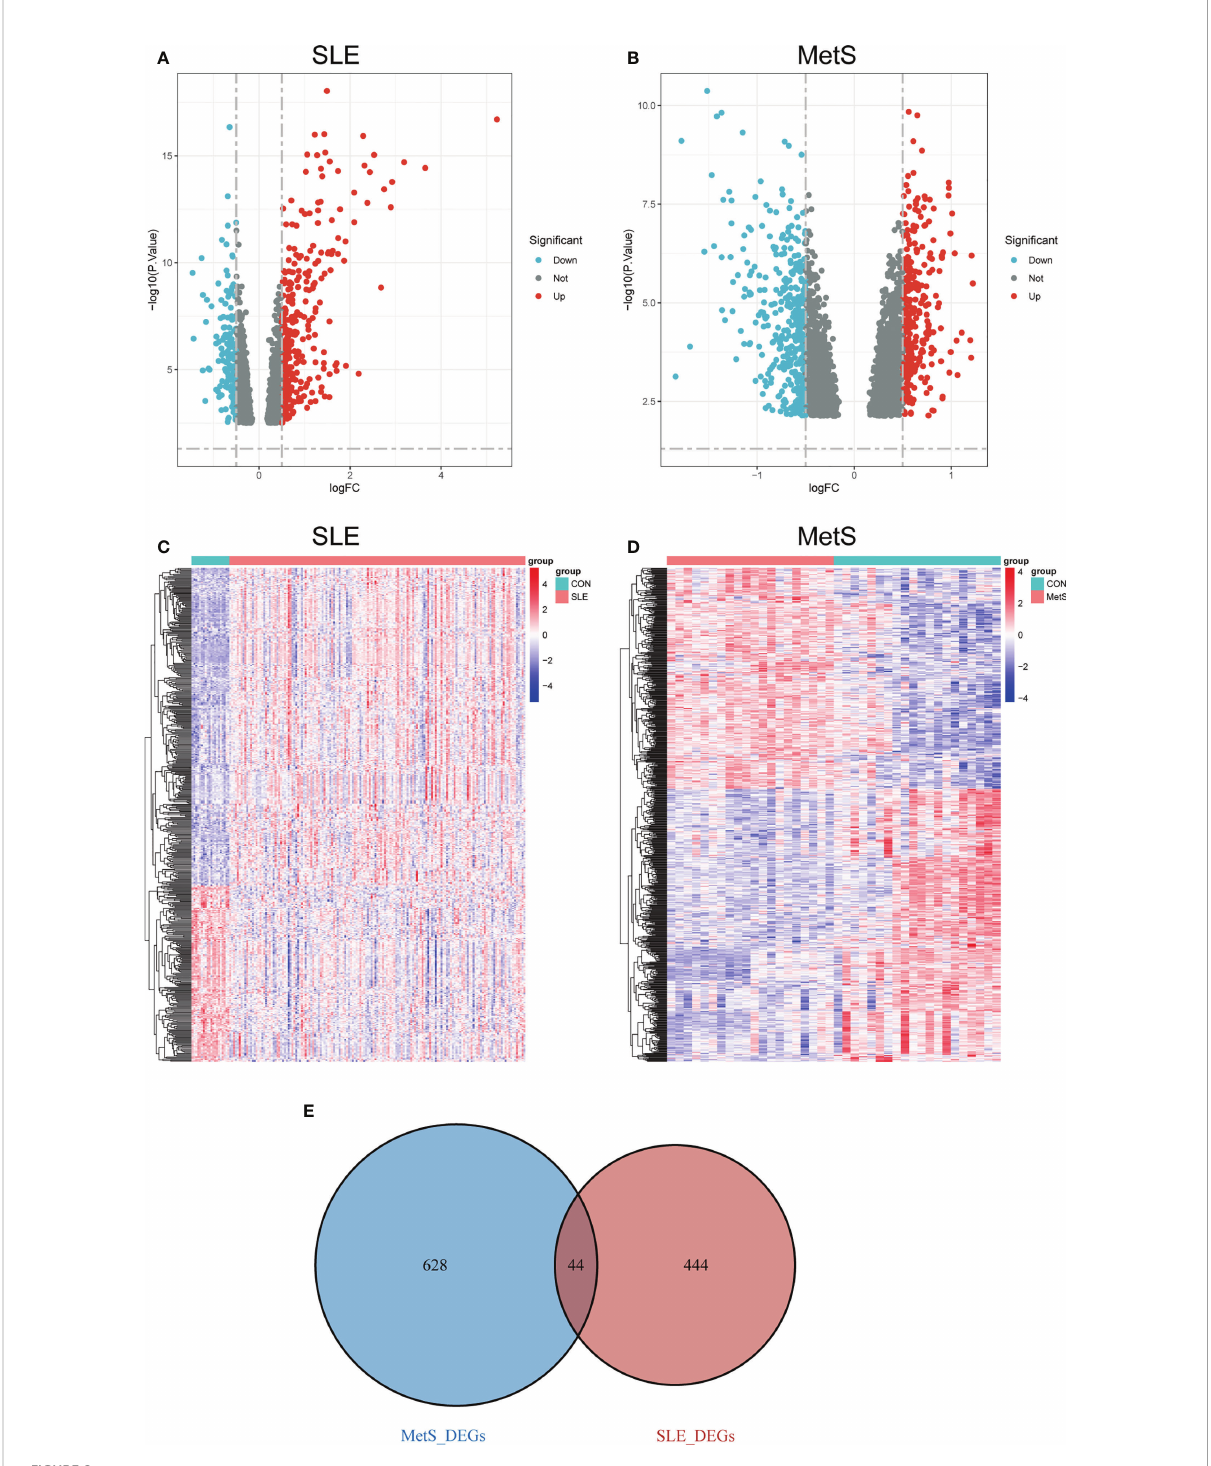
FIGURE 2 (A) Volcano plot of DEGs in GSE72326 |log2FC| > 0.5). (B) Volcano plot of DEGs in GSE98895 |log2FC| > 0.5). Red: upregulated; blue: downregulated. (C) Heatmap of DEGs in GSE72326. (D) Heatmap of DEGs in GSE98895. (E) Overlapping DEGs of GSE72326 and GSE98895. Volcano plots showed the genes that are up- or down-regulated in the data sets, with red dots indicating signi fi cant up-regulation and blue dots indicating signi fi cant down-regulation. Heatmaps exhibited the expression levels of genes in each sample in the data